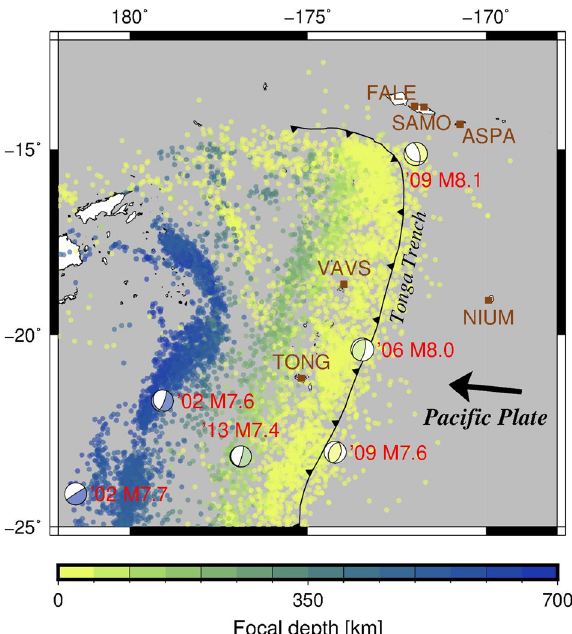
Figure 1. Seismicity map around the Tonga subduction zone, where the Pacific Plate subducts from the Tonga Trench. The coloured points show earthquakes during 2002–2017, the magnitudes of which are ≥ 4.5 as per the Advanced National Seismic System (ANSS) Comprehensive Earthquake Catalog (ComCat). Colour indicates focal depth. The beach-ball symbols and the red labels indicate the global Centroid Moment Tensor (CMT) solutions for large earthquakes, with magnitudes ≥ 7.4. The brown squares and labels indicate the Global Navigation Satellite System (GNSS) stations and their names. Figure generated with Generic Mapping Tools 5.x (https ://www.gener ic-mappi ng-tools